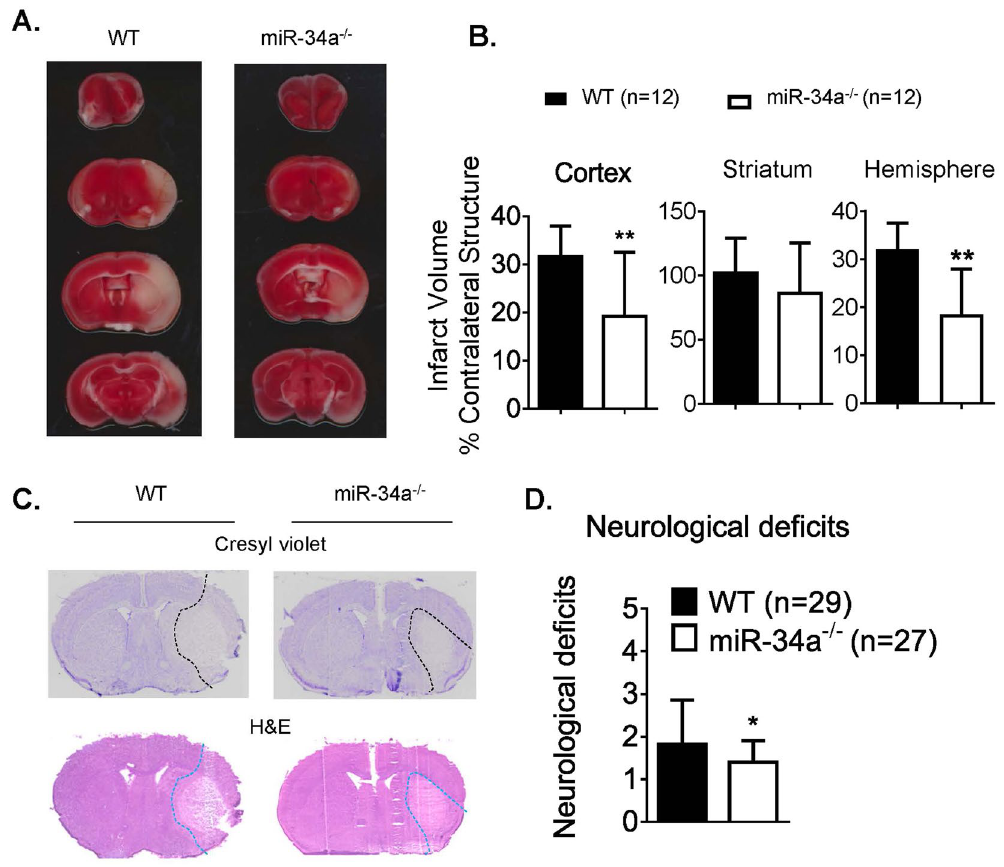
Figure 3. miR-34a depletion reduces stroke infarction and improves neurological deficits. ( A ) Representative TTC staining from WT and miR-34a − / − mice following 1 h tMCAO and 24 h reperfusion. ( B ) Quantified infarct volumes showed a significant decrease in miR-34a − / − mice, ** p < 0.01 WT vs miR-34a − / − mice (n = 12 per group). Student’s t test (two-tailed) was used for data analysis. ( C ) Representative Cresyl violet staining (infarction outlined by black dash lines) and H&E staining (infarction outlined by blue dash lines) from coronal brain sections of WT and miR-34a − / − mice following 1 h tMCAO and 24 h reperfusion. ( D ) Neurological deficits of animals generated data for stroke infarction and BBB permeability at 6 h and 24 h end-points. * p < 0.05, WT (n = 29) vs miR-34a − / − (n = 27) mice. Student’s t test (one-tailed) was used for data analysis. Data are expressed as mean ±